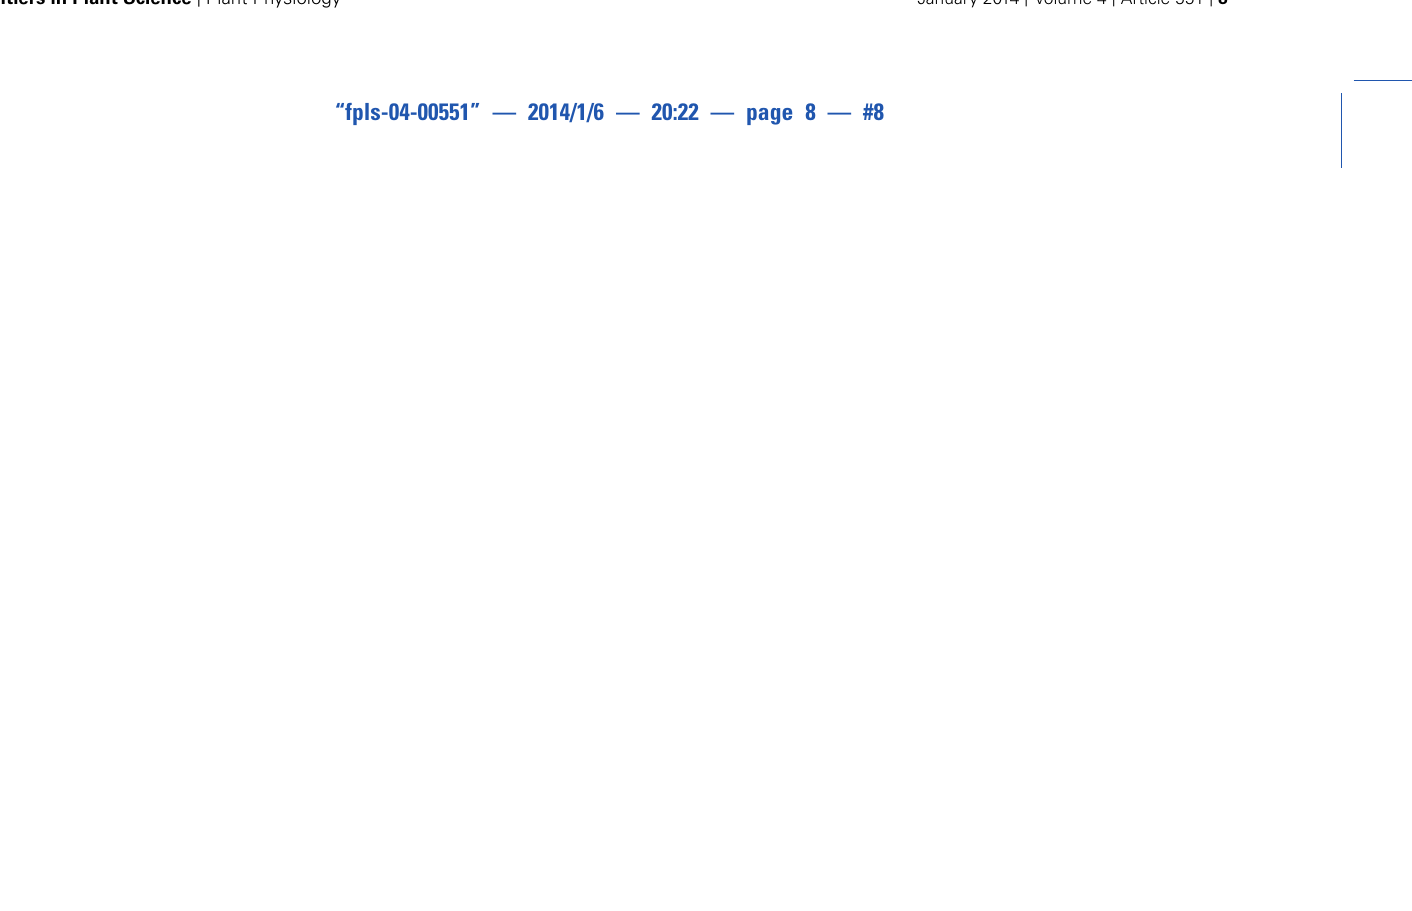
FIGURE 3 | Integrative view of different regulatory pathways involved in mitochondrial biogenesis. Mitochondrial biogenesis is regulated by numerous external factors, such as nutrient availability, environmental stimuli, light/dark conditions, diurnal cycle, and oxidative stress situations, among others (1) . Mitochondrial biogenesis is also internally regulated by different stages of development, organ/tissue type, hormones, and cell energy and metabolic demands (2) . The expression of a majority of nuclear genes for mitochondrial proteins is controlled by elements known as site II that are recognized by TCP transcription factors (3) . Site II elements are either responsible for basal gene expression or